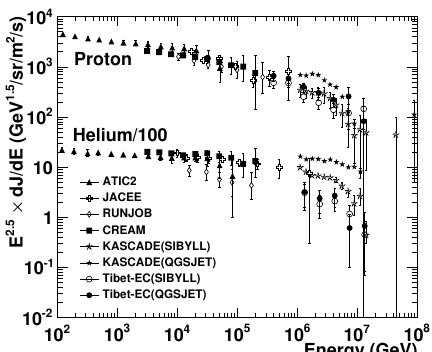
Figure 1. Energy spectra of primary cosmic-ray proton and helium nuclei obtained by Tibet-EC [4] compared with some other experimental results: ATIC2 [6], JACEE [7], RUNJOB [8], CREAM [9], KASCADE